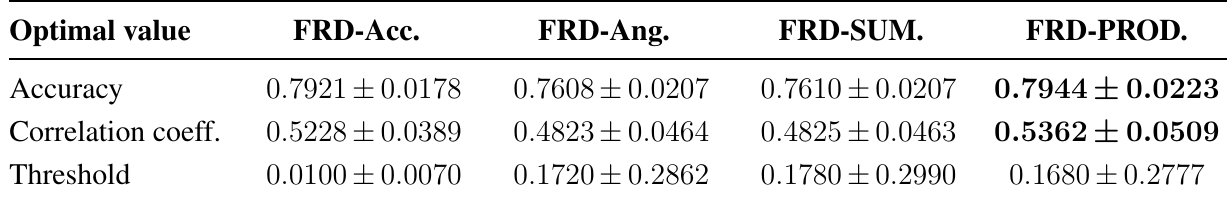
Table 6. Results of the Monte Carlo simulation ( N = 500 ). Synthesized signals. Average Accuracy, Correlation coefficient and associated parameters (Filtered Rectifier Detector).